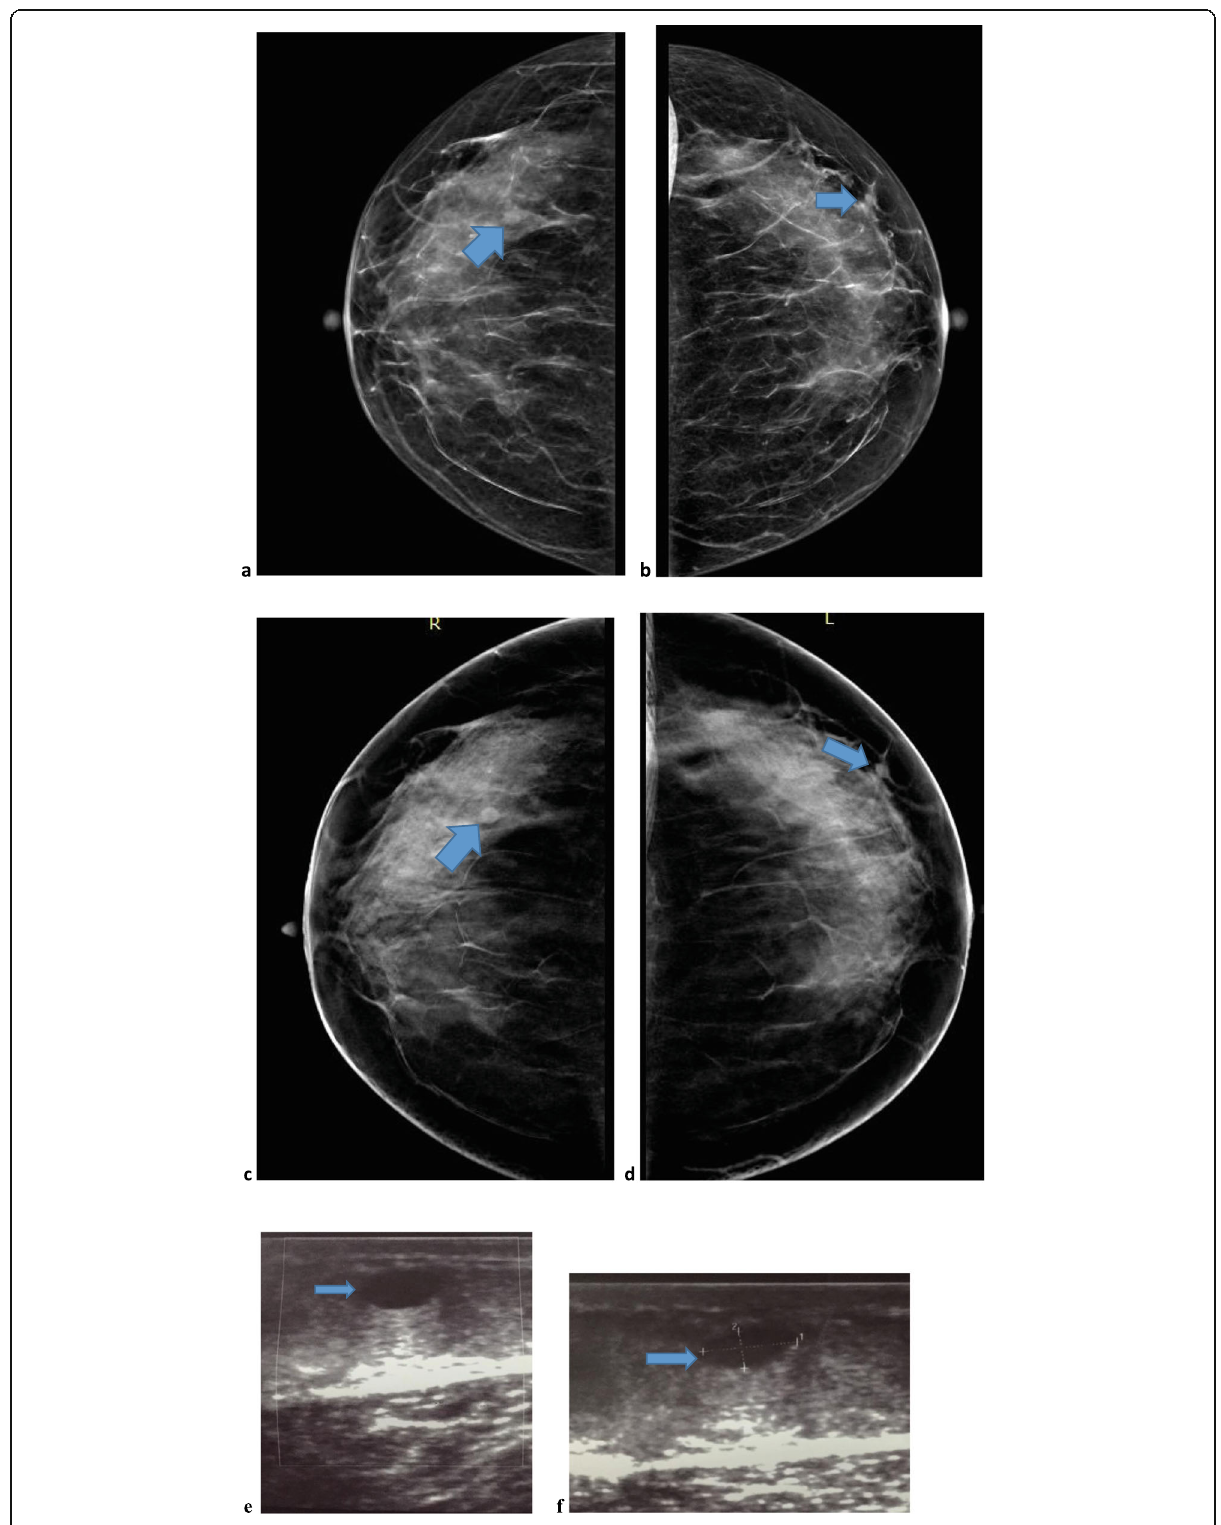
Fig. 4 (See legend on next